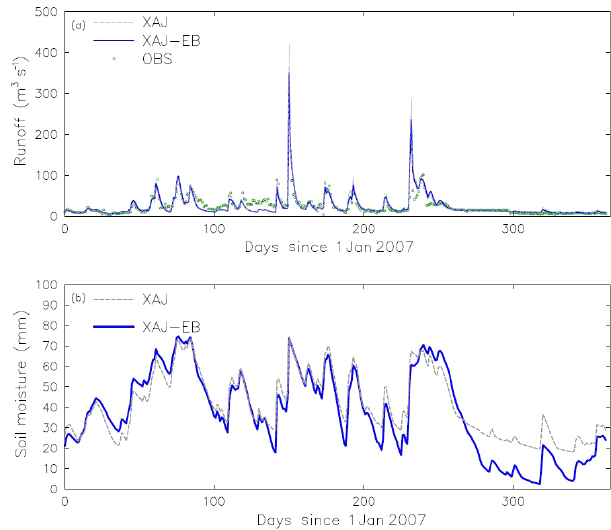
Figure 11. Comparison between XAJ-EB and Noah-MP-modeled catchment-average latent heat flux (a) and land surface tempera- ture (b) . Panel (c) illustrates the comparison between catchment- average precipitation used by XAJ-EB and